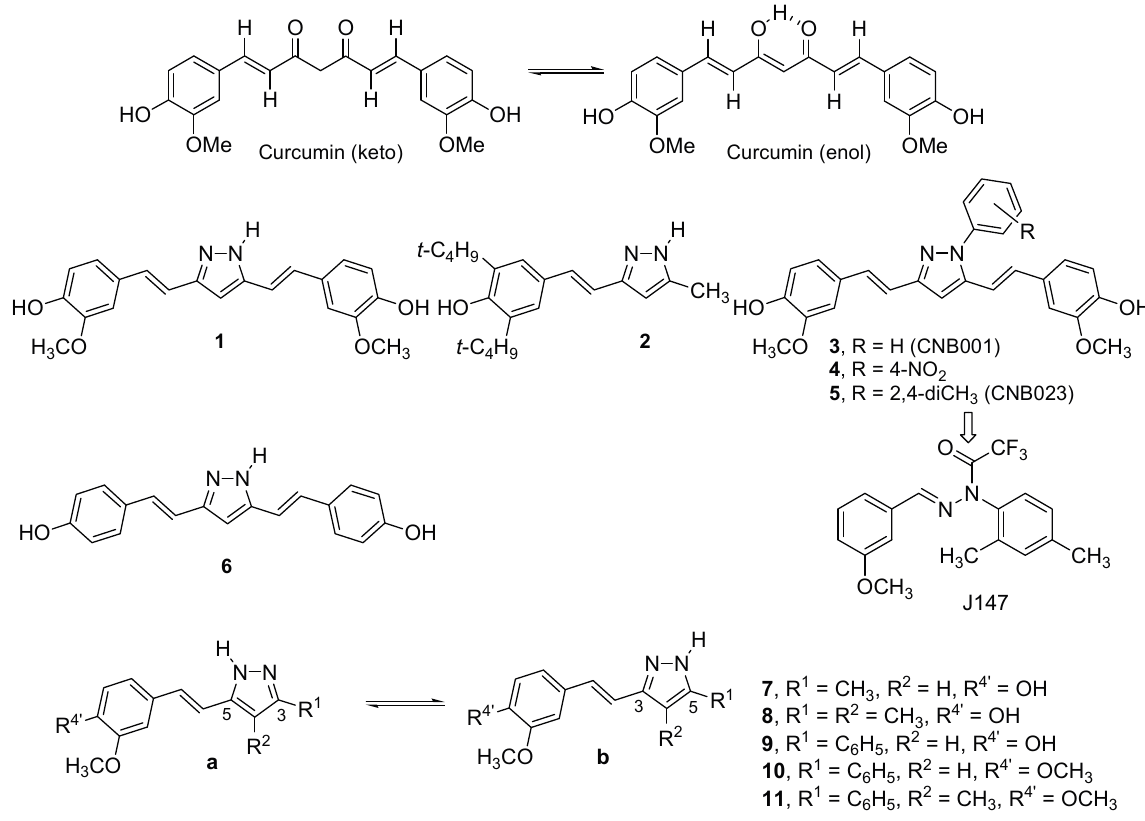
Figure 1. Curcuminoid pyrazoles, from the literature 1 – 6 and reported in our previous